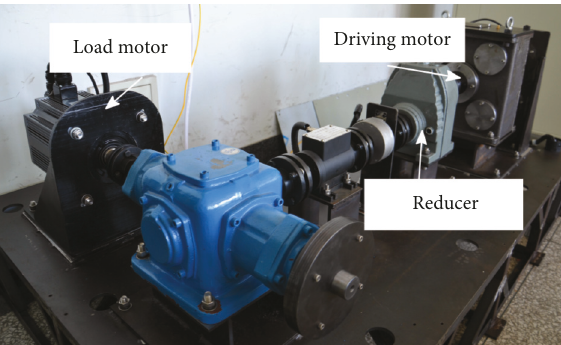
Figure 10: Motor driving test